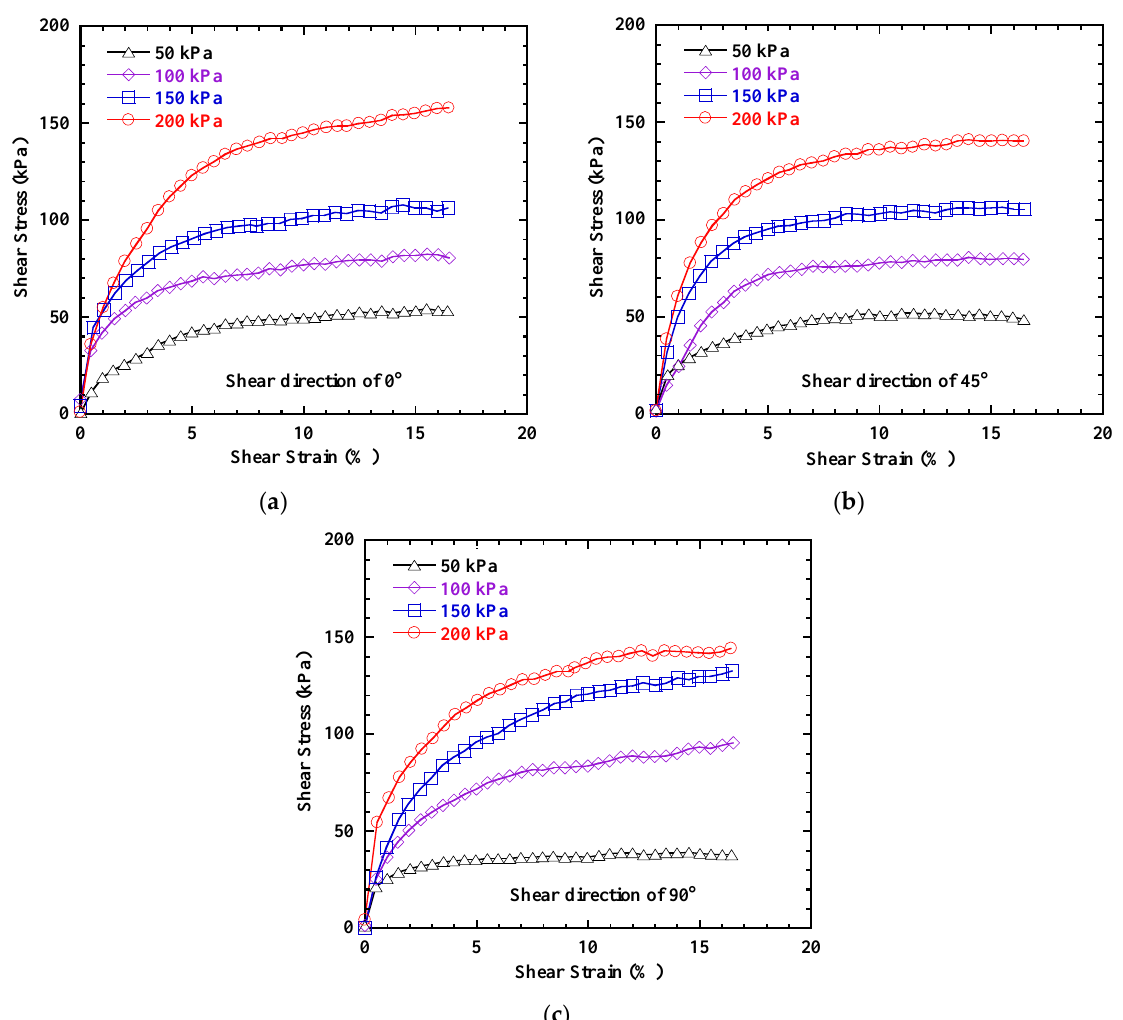
Figure 5. Shear stress–strain curves for fine sand–triaxial geogrid (TX160) interfaces. ( a ) Shear direction of 0°, ( b ) shear direction of 45°, ( c ) shear direction of 90°.